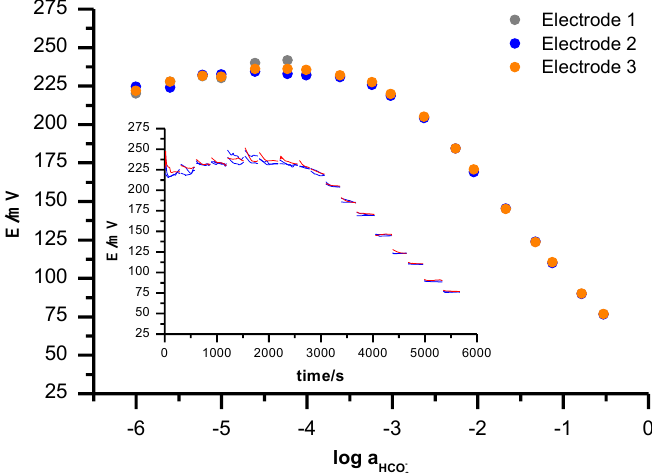
Figure 4. Potentiometric calibration curve and potential change over time (insert) of bicarbonate sensitive electrodes (n = 3) with a polymer matrix of divinylbenzene cross-linked polystyrene obtained during measurements in NaHCO 3 solutions in the concentration range 10 − 6 –5 · 10 − 1 mol L −